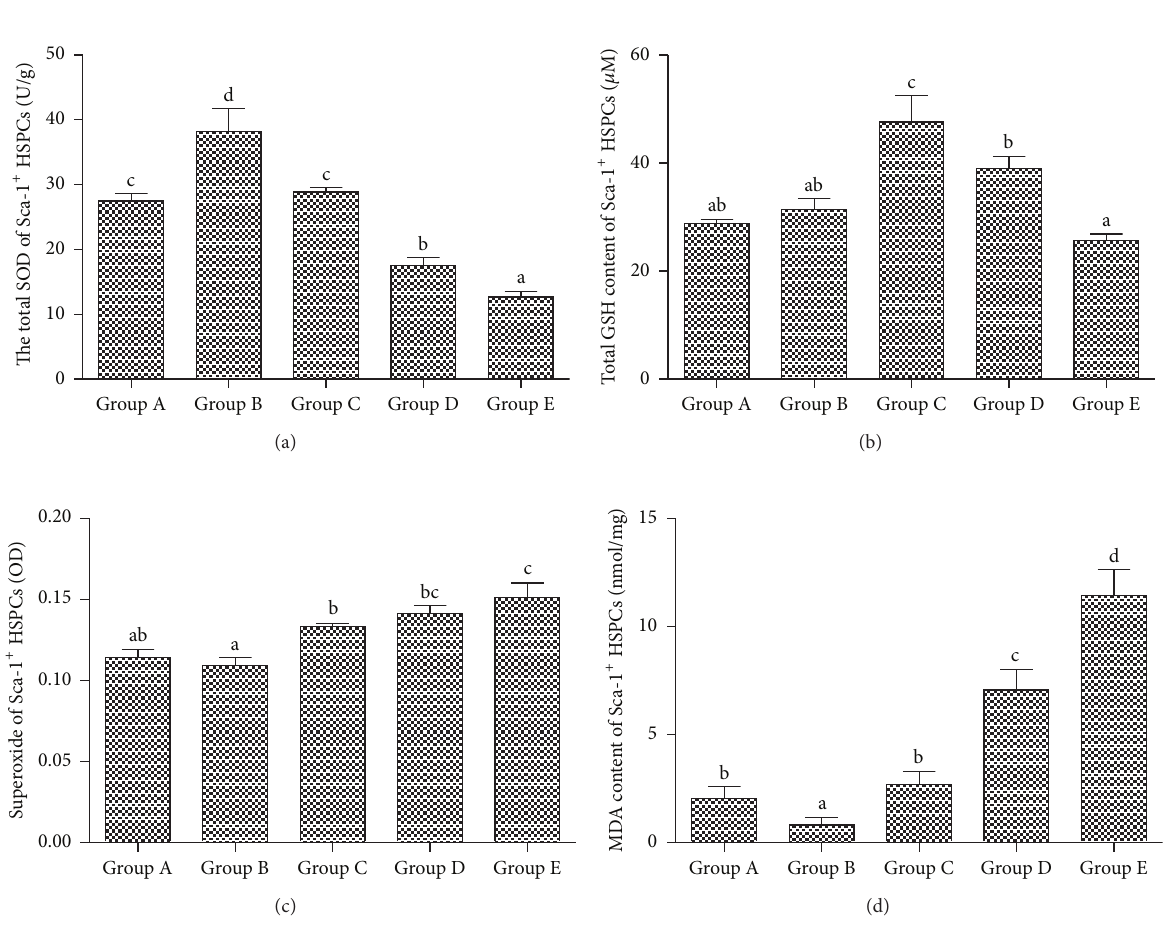
Figure 2: The superoxide damage and the antisuperoxide ability of Sca-1 + HSPCs by aging. (a) The activities of SOD of each sample (U/g, 𝑥 ± 𝑠 , 𝑛 = 10 ). (b) Glutathione contents in each group ( 𝜇 M, 𝑥 ± 𝑠 , 𝑛 = 10 ). (c) The absorbance value of each group which is proportional to superoxide (OD, 𝑥 ± 𝑠 , 𝑛 = 10 ). (d) MDA contents of Sca-1 + HSPCs in each group (nmol/mg, 𝑥 ± 𝑠 , 𝑛 = 10 ). Group A: 3-4-week-old mice, 13–16g in body weight. Group B: 8-9-week-old mice, 20–25 g in body weight. Group C: 6-month-old mice, 35–40 g in body weight. Group D: 12-month-old mice, 39–43 g in body weight. Group E: 18-month-old mice, 37–45 g in body weight. (a–d) represent a significant